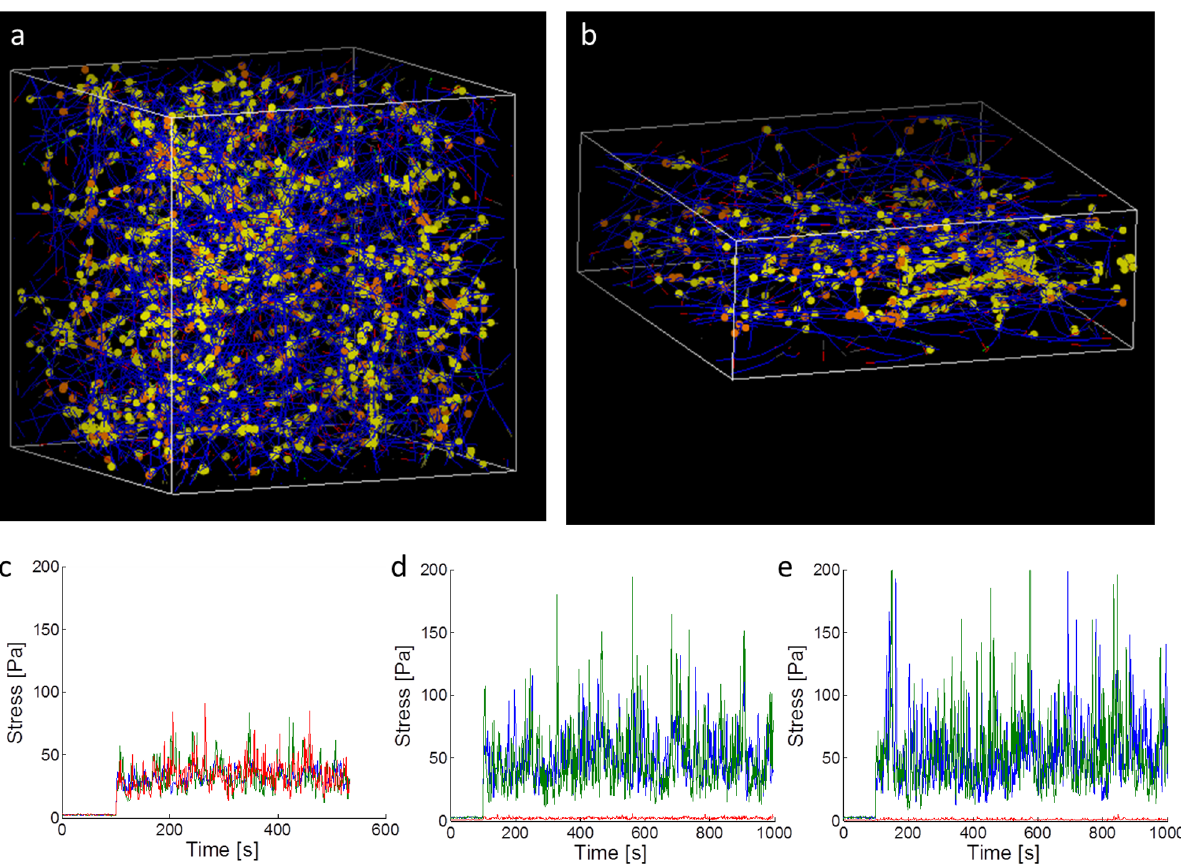
Figure 6. Brownian dynamics simulations of active actin networks. a) A 3D 3 6 3 6 3 m m 3 (in the x, y, and z directions, respectively) domain with periodic boundary conditions on all sides, mimicking the cytoskeletal network in 3D. Actin filaments (blue) are polymerized from G-actin monomers and allowed to bind to myosin II motors (orange) and crosslinkers (yellow). Motors walk along two filaments toward their barbed ends, generating internal stress. b) A 3D 3 6 3 6 1 m m 3 domain with periodic boundary conditions in the x and y directions and fixed boundaries in the z- direction, mimicking a 2D cell configuration. The actin network is more planarized, as the filaments align along the x-y plane. c,d,e) Average internal stresses in the x (blue), y (green), and z (red) directions for (c) a 3D network, (d) a 2D network with 1 m m height in the z-direction, and (e) a 2D network with 500nm height in the z-direction. 2D networks have larger stress fluctuations from the mean in the x and y directions (the plane of interest in experiments), but reduced fluctuations in z, as compared to 3D networks. 3D networks have comparable average internal stresses in all 3 dimensions. 2D networks have reduced average stresses in the z-direction (perpendicular to the plane of filament alignment), generating mechanical anisotropy. The stresses for each time point for each simulation were calculated by summing the tensional forces of filaments crossing a total area of